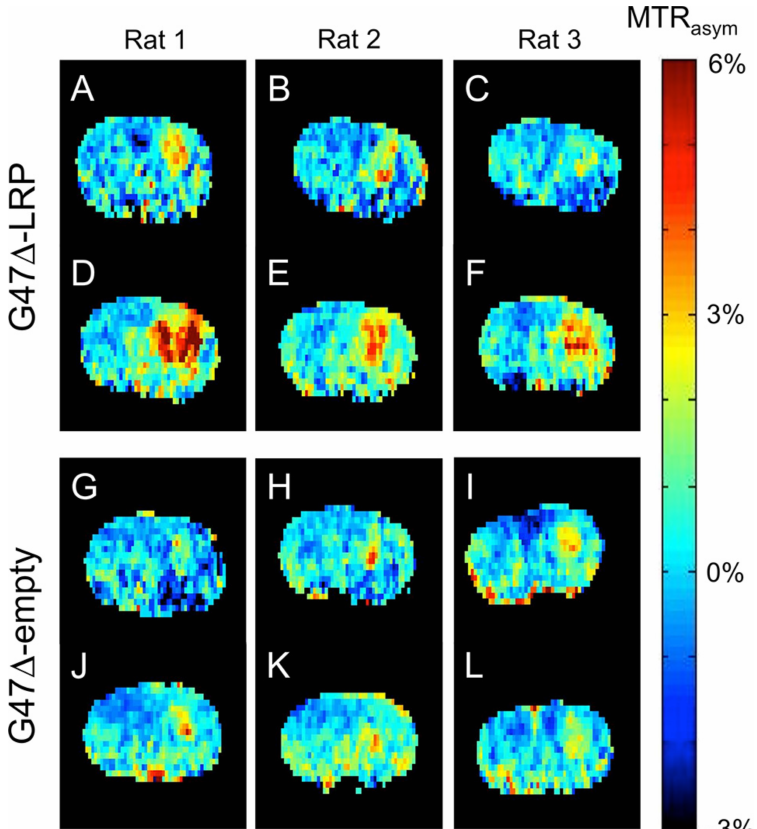
Figure 6. Oncolytic virotherapy monitoring using a CEST reporter gene. CEST-weighted images were acquired from three rats before ( A – C , G – I ) and 8–10 h after ( D – F , J – L ) the inoculation of an LRP expressing (top) or empty (bottom) G47 ∆ virus. An increased CEST signal at the tumor was obtained for the LRP OV expressing group ( D – F ) but not in the control group ( J – L ). Reprinted with permission from Farrar et al. Radiology 275(3), pp. 746–754 (2015) [170]. Copyright ©2015 Radiological Society of North America